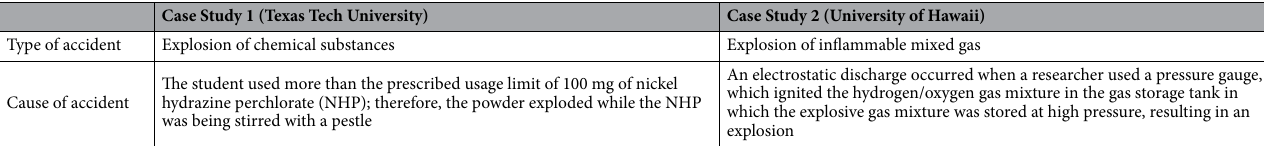
Table 1. Types and causes of accidents.